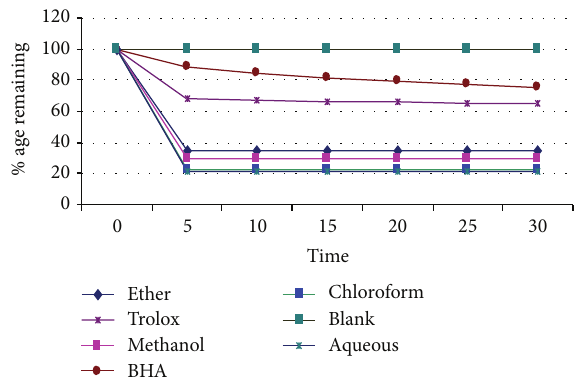
Figure 19: DPPH kinetic curve of bark extract of C. ambrosioides